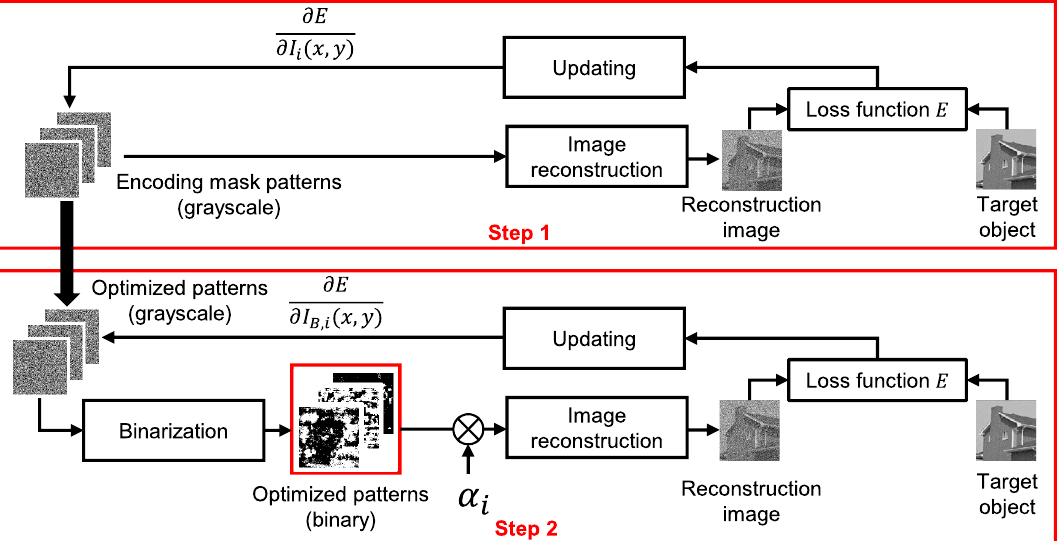
Figure 8. Procedure of the patterns optimization. In step 1, “Image reconstruction” calculates Eq. (1) without α i . “Loss function” E is a mean squared error. “Updating” performs gradient descent. “Binarization” performs I